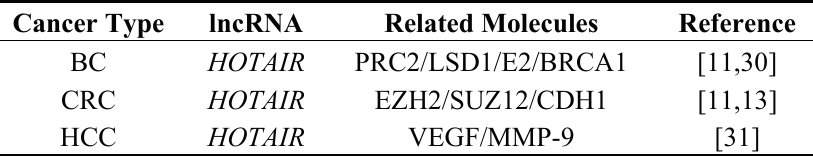
Table 2. HOTAIR -related signaling molecules.